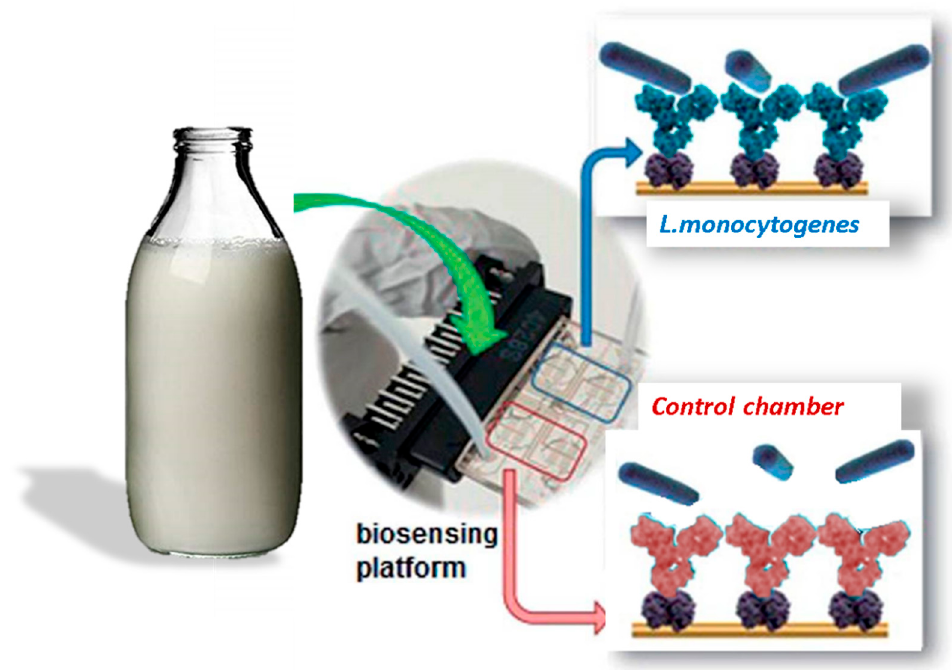
Figure 2. Scheme of the performance of electrochemical impedance spectroscopy (EIS) biosensing, incubation of antibodies with samples, and specific recognition of antigens by interacting